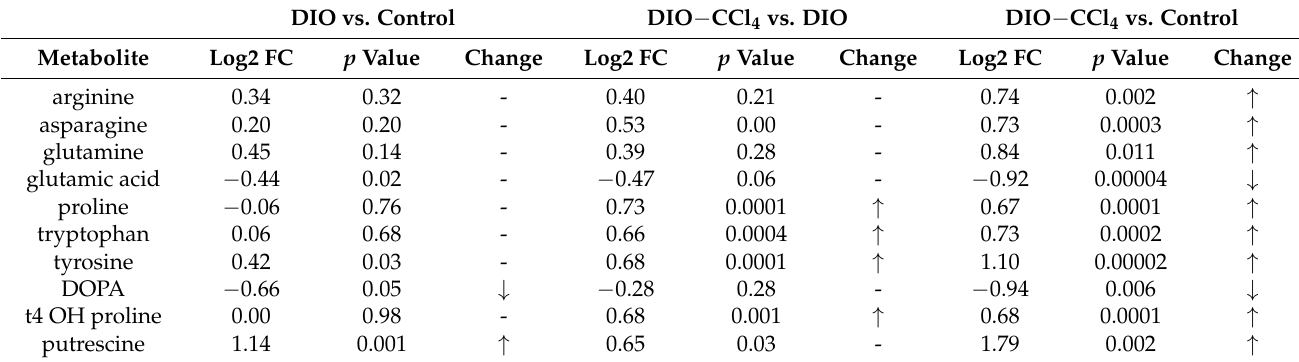
Table 1. Summary of differential metabolites in liver between different groups (amino acids). DIO vs. Control